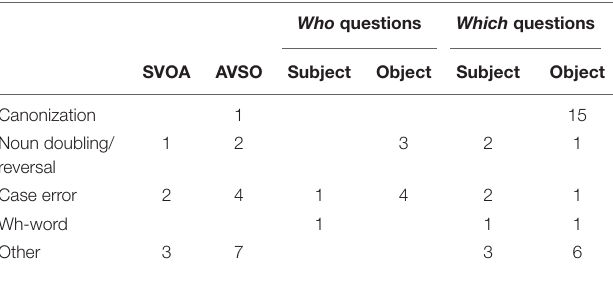
TABLE 8 | Experiment 4 – structural errors in repetition: number of errors per sentence